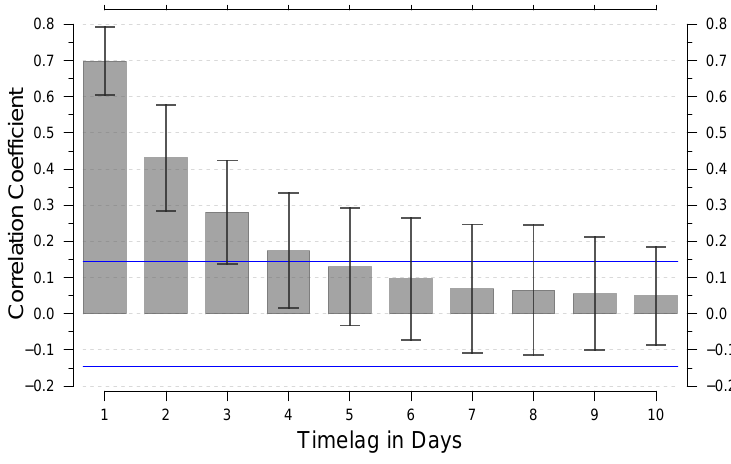
Figure 2. Auto-correlation function based on the MODIS-derived polynya area in the Brunt Ice Shelf region (Figure 1) from 1 April to 30 September for the years 2002 to 2013. Presented in gray bars are the auto-correlation coefficients against the absolute time lag in days, i.e. , a negative, as well as a positive displacement. Values above the blue line indicate a significant correlation, given a level of significance ( α ) of 5%. Error bars indicate ± 1 standard